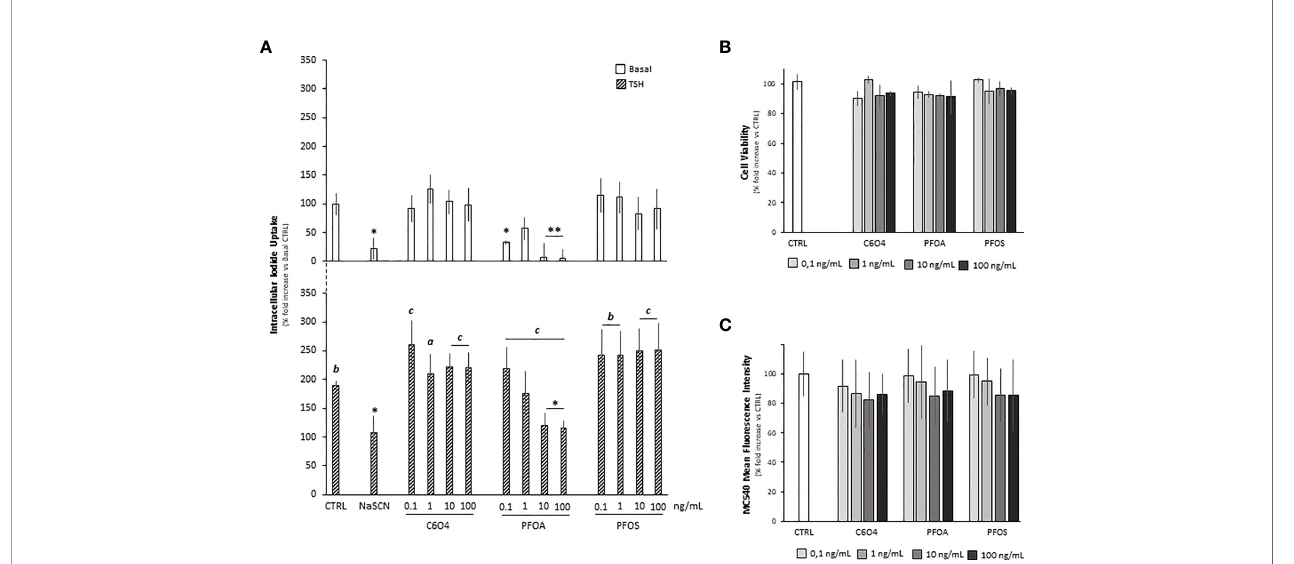
FIGURE 1 | (A) Evaluation of cell iodide uptake, at basal condition (Basal)and upon stimulation with 1 mU/ml thyroid stimulating hormone (TSH), in FRTL-5 normal rat thyrocyte cell line exposed for 24 hours to acetic acid, 2,2-di fl uoro-2-[(2,2,4,5-tetra fl uoro-5(tri fl uoromethoxy)-1,3-dioxolan-4-yl)oxy]-ammonium salt (1:1) (C6O4), per fl uoro-octanoic acid (PFOA) per fl uoro-octane-sulfonic acid (PFOS) at concentration ranging from 0.1 to 100 ng/mL. Reference inhibition of iodide uptake was obtained by incubation with 50 m M sodium thiocyanate (NaSCN). Experiments were performed in triplicate and normalized as percentage fold increase on basal control laking TSH stimulus and exposure to per fl uoroalkyl substances (CTRL). Data are reported as mean values ± standard deviation. Signi fi cance: *P < 0.05, **P < 0.01 vs corresponding CTRL; a=p < 0.05, b=p < 0.01 and c=p < 0.001 vs corresponding basal). Evaluation of FRTL-5 cell viability (B) and cell mebrane fl uidity (C) upon exposure to C6O4, PFOA or PFOS exposed for 24 hours at concentration ranging 0.1 to 100 ng/mL. In CTRL, exposure was omitted. Cell viability was evaluated by MTT assay and membrane fl uidity by merocyanine-540 staining as described in methods. Experiments were performed in triplicate and normalized as percentage fold increase on CTRL. Data are reported as mean values ± standard